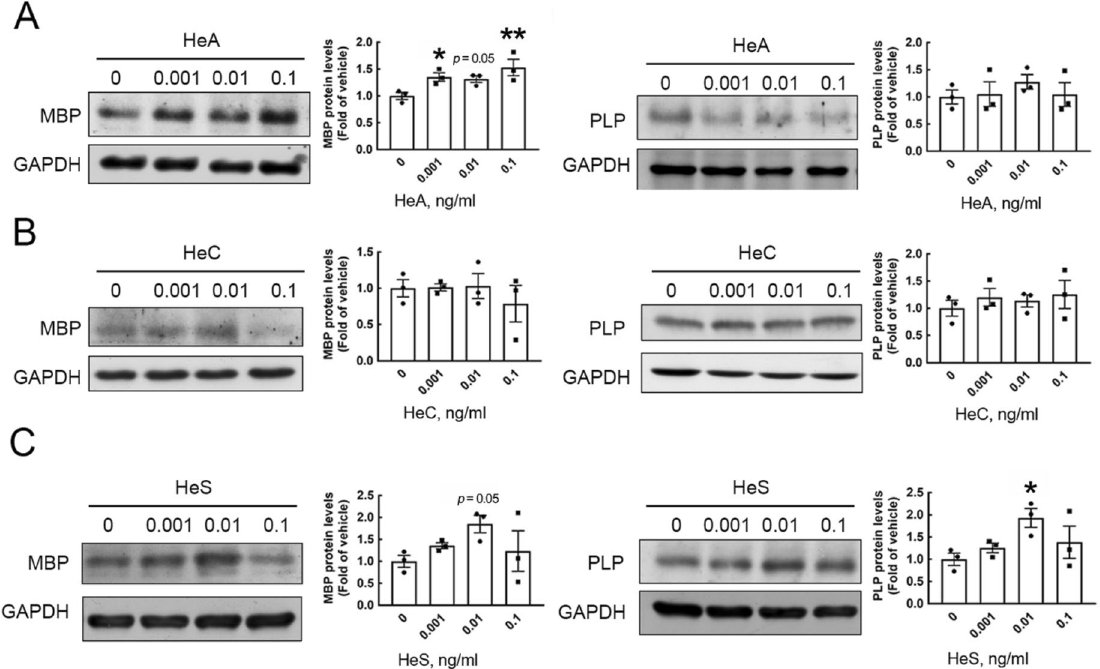
Figure 5. HeA and HeS increased MBP protein production in OL cultures. OPCs were first maintained in DM for 2 days and then exposed to HeA, HeC, or HeS at the indicated concentrations for another 3 days (Fig. 1B). Total proteins were extracted from the cultures and subjected to Western blot analysis to examine MBP ( A ) and PLP ( B ) protein levels. The GAPDH level was used as a loading control. The intensity of the immunoreactive bands shown in the immunoblots was quantified by ImageJ software version 1.52a (https:// imagej. nih. gov/ ij/), and normalized to the level of GAPDH, which was used as a loading control. The results are presented as the means ± SEMs of three repeated experiments. The raw immunoblot images are shown in Figs. S6, S7, and S8. * p < 0.05, ** p < 0.01 compared with the control